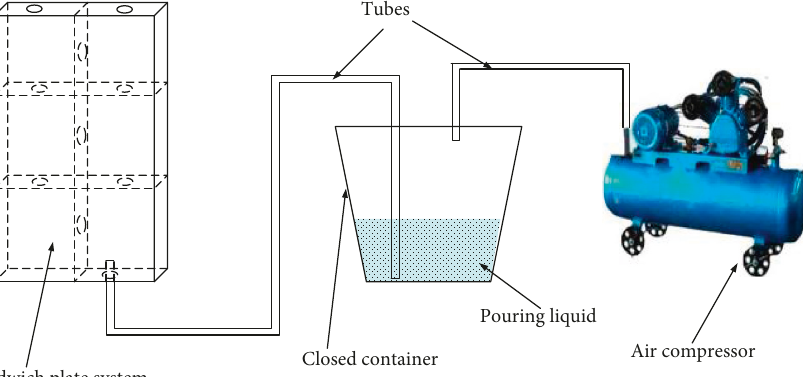
Figure 17: Preparation process of the SPS